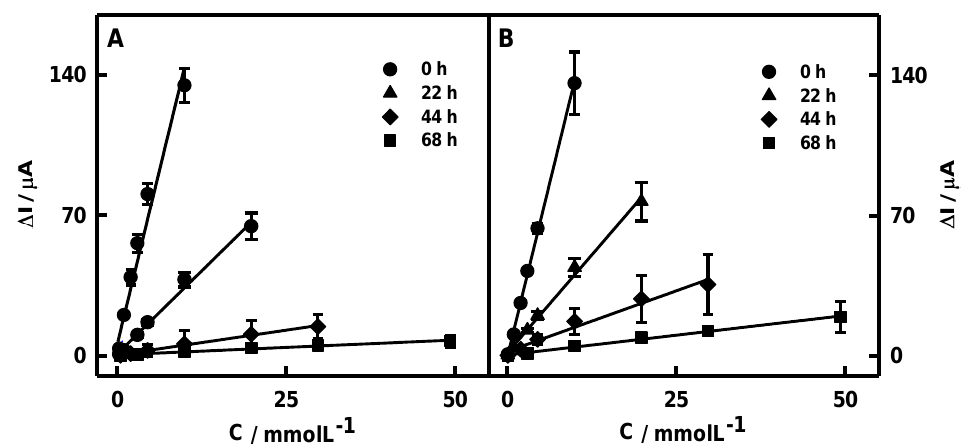
Figure 4. The linear glucose determination ranges of biosensors based on the PANI/GOx/DGNs/GR ( A ) and Ppy/GOx/DGNs/GR ( B ) electrodes when polymerization was performed for 0, 22, 44, and 68 h.